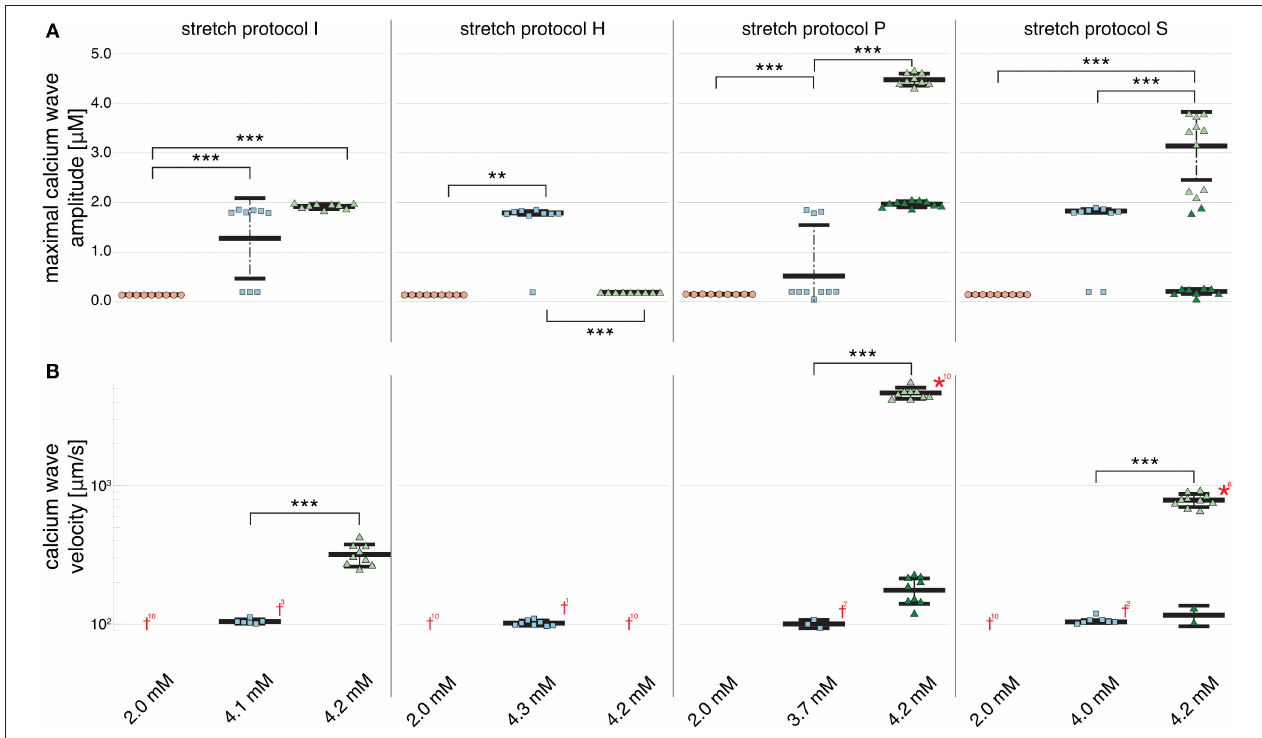
FIGURE 2 | Maximal calcium wave amplitude magnitude and calcium wave velocity in cardiomyocyte simulations at different extracellular calcium concentrations for control (no stretch protocol I), and stretch patterns H, S, and P. (A) The magnitude of the measured maximal calcium wave amplitude increased significantly for all stretch patterns from Ca o = 2.0 mM (red data points) to the extracellular calcium concentration at which a calcium wave occurred (blue data points), and 4.2 mM (green data points). Red daggers indicate that no calcium waves occurred in the data set, while red asterisks indicate that the calcium waves triggered additional beats. The related numbers specifies the amount of occurrences within the data set. The data points in light colors specify the first spontaneous event and dark colors are used for the following spontaneous event. (B) The calcium wave velocity increased for all simulations from Ca o = 2.0 mM (no waves) to 4.2 mM and from control, to stretch patterns H, to S, and to P. **, *** indicate the statistical significance with p < 0.05 and p < 0.1, respectively.